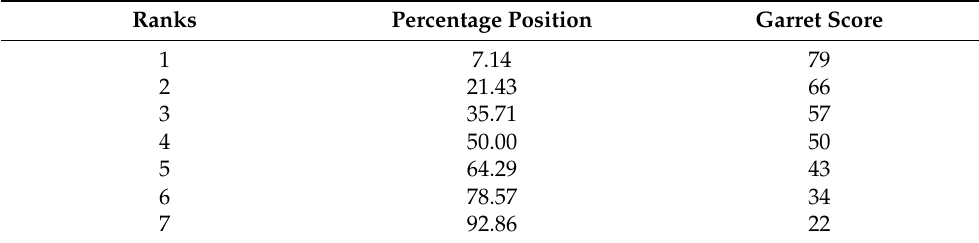
Table 5. Percentage position and Garrett value for rank 1 to